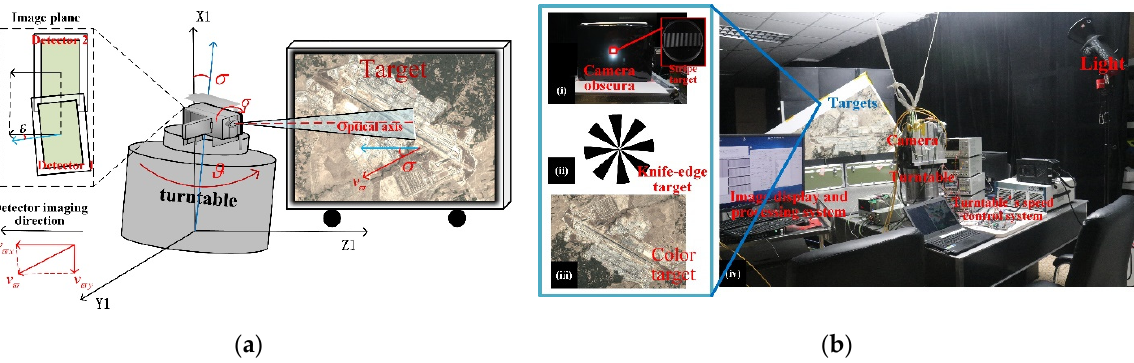
( b ) ( c ) Figure 4. Roll angel and velocity vector: ( a ) The curve of roll angle; ( b ) The value of drift angles at 2367 s; ( c ) the distribution of velocity vectors on the image plane at 2367 s. The experiment simulates the imaging process of the swing mirror at 2367 s. Figure 5 shows the imaging principle and facilities of the experiment. The turntable is equipped with a horizontally placed camera and rotates at angular velocity